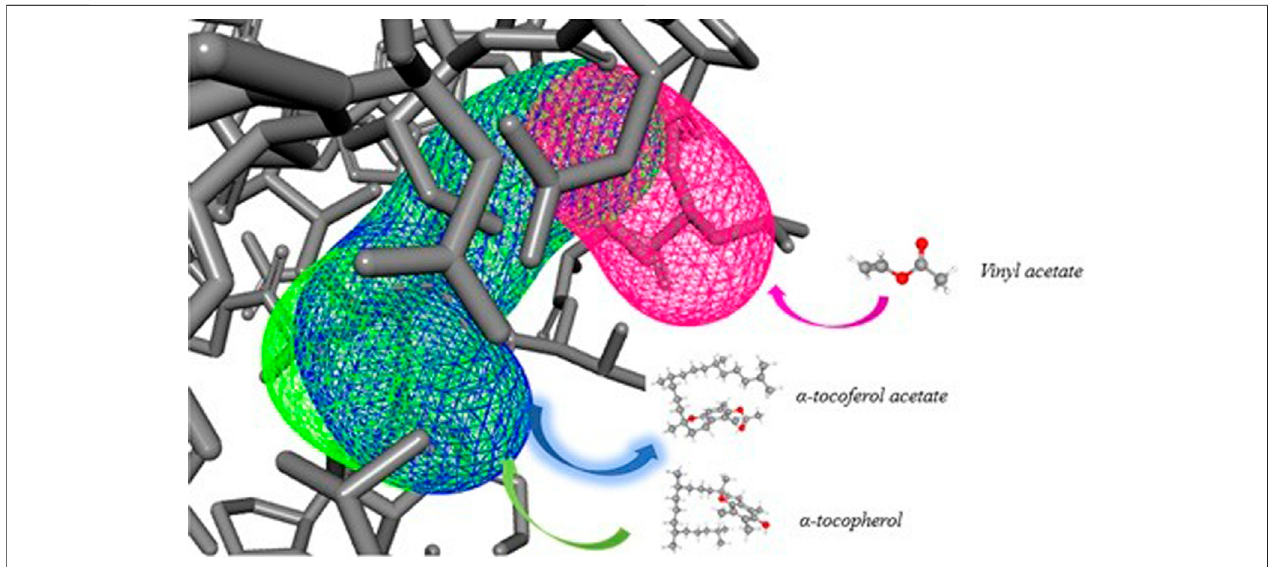
FIGURE 10 | Representative diagram of the 3 most promising tunnels for transport in CALB, in pink (tunnel 1), blue (tunnel 2), and green (tunnel 3) and the demonstration of binder entry and exit of the product.